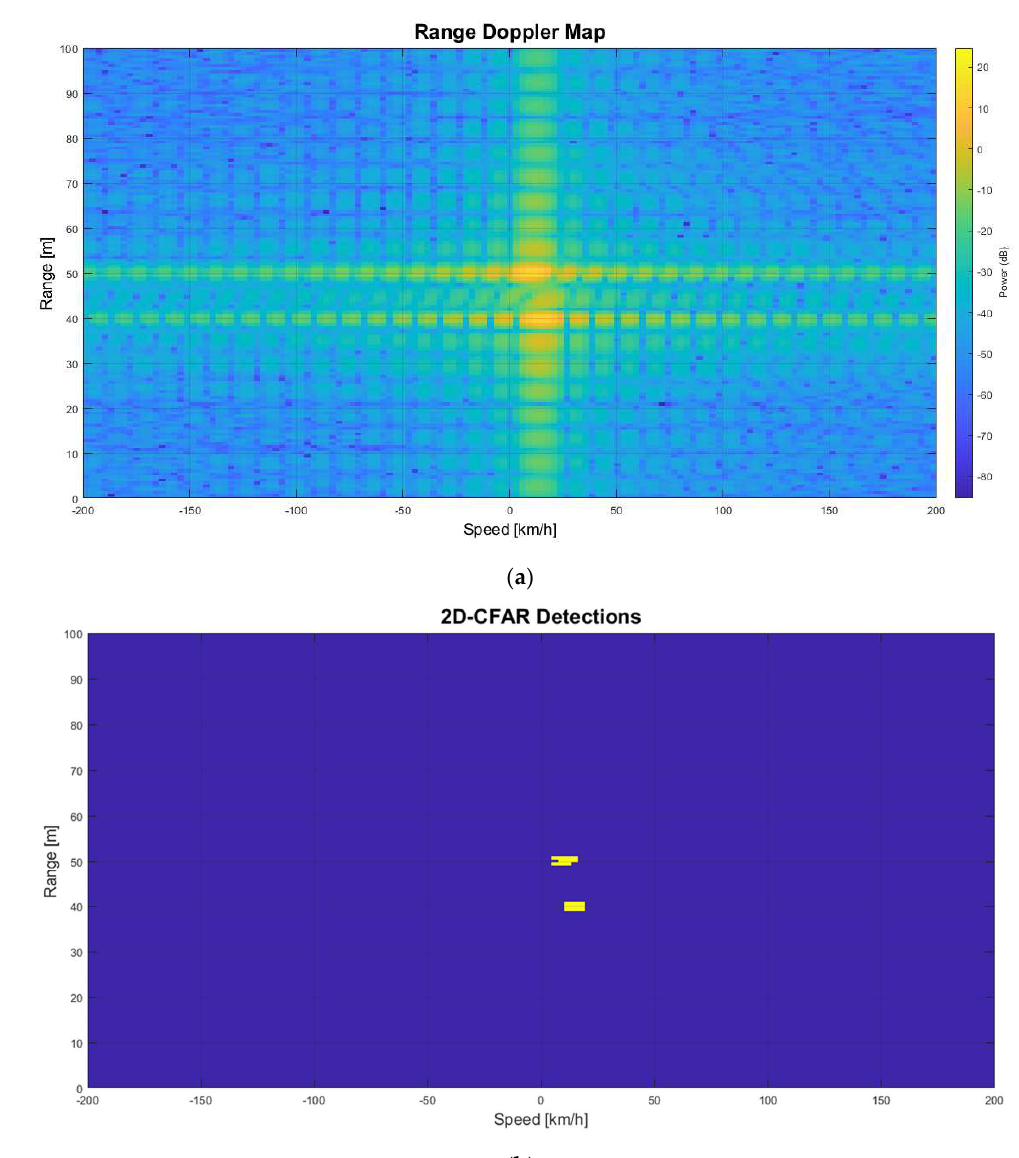
Figure 10. Jamming with JSR = 1. ( a ) Range-Doppler Map; ( b ) 2D-CFAR Detection. When the jamming power level is increased to JSR = 10 dB, the LRR increases the detection threshold, and the real object could not be detected as the jamming signal has more power. Figure 11a,b shows the RDM and the 2D-CFAR detection, respectively, when the JSR is 10 dB. In this case, the real echo could not be detected by the CFAR. Only ghost echo is detected at a range of 40 m and relative speed of 15 km/h.